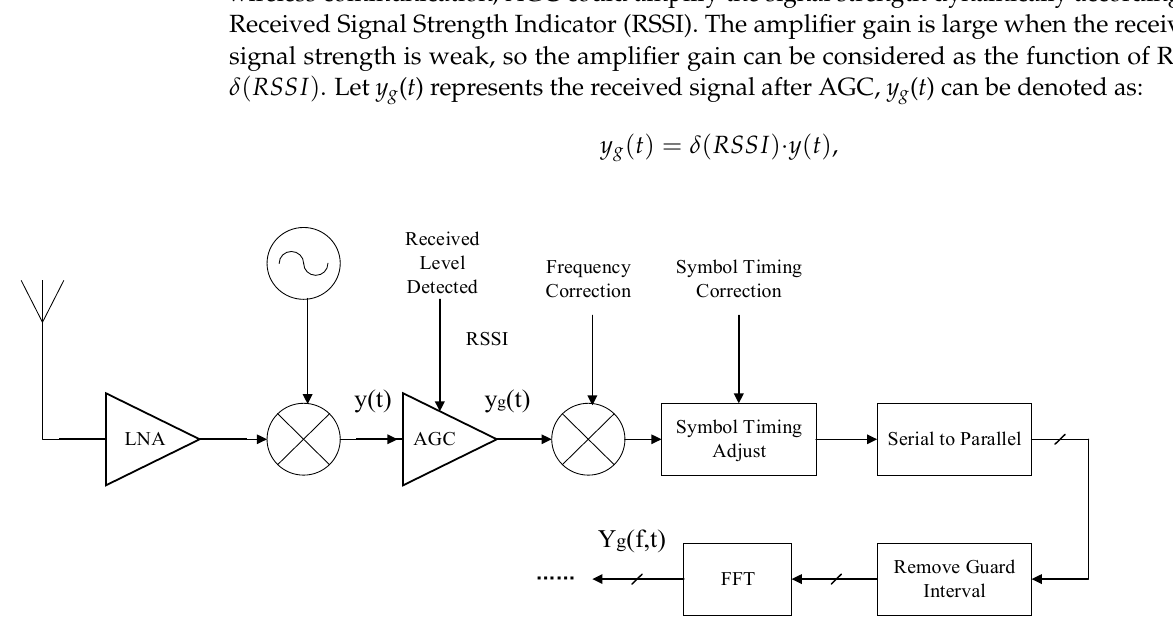
Figure 1. The signal processing in the Wi-Fi receiver block diagram.